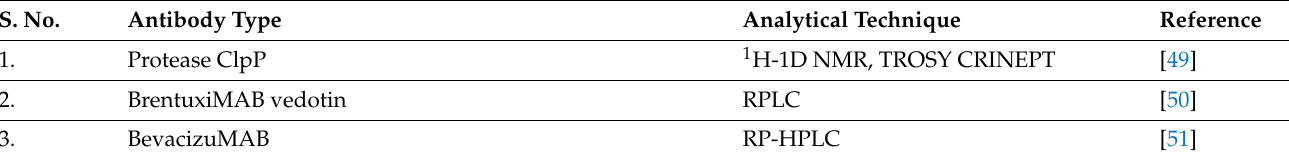
Table 2. Recent analytical techniques reported for the characterization of